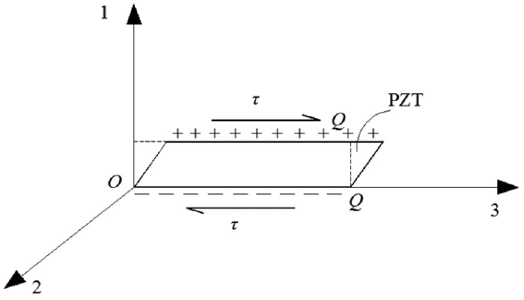
Figure 1. Direct piezoelectric effect of a shear-type piezoelectric ceramic [7, 8].